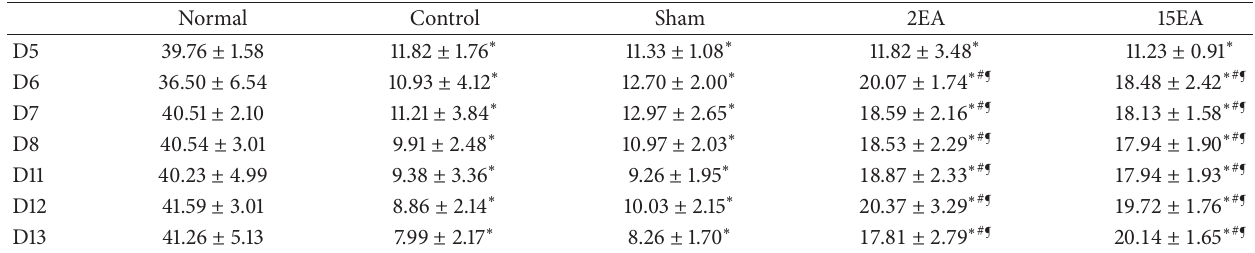
Table 3: Effect of electroacupuncture (EA) on von Frey test in SD rats with chronic constriction injury (CCI)-induced neuropathic pain